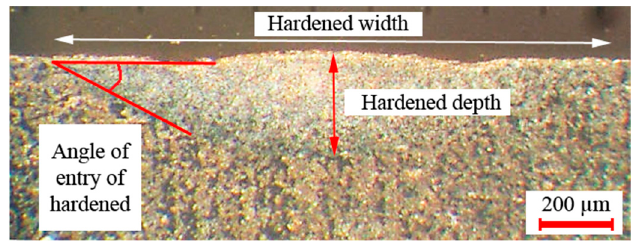
Figure 1. Width of hardened case, depth of hardened case, and angle of entry angle of hardened areas.